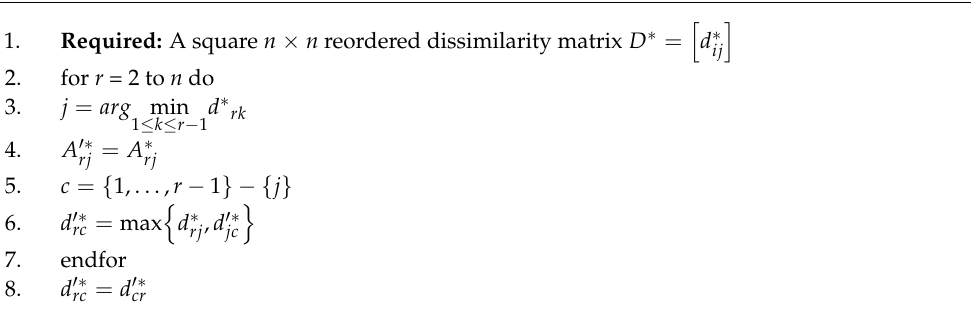
Algorithm 2. Improved visual assessment of the clustering tendency